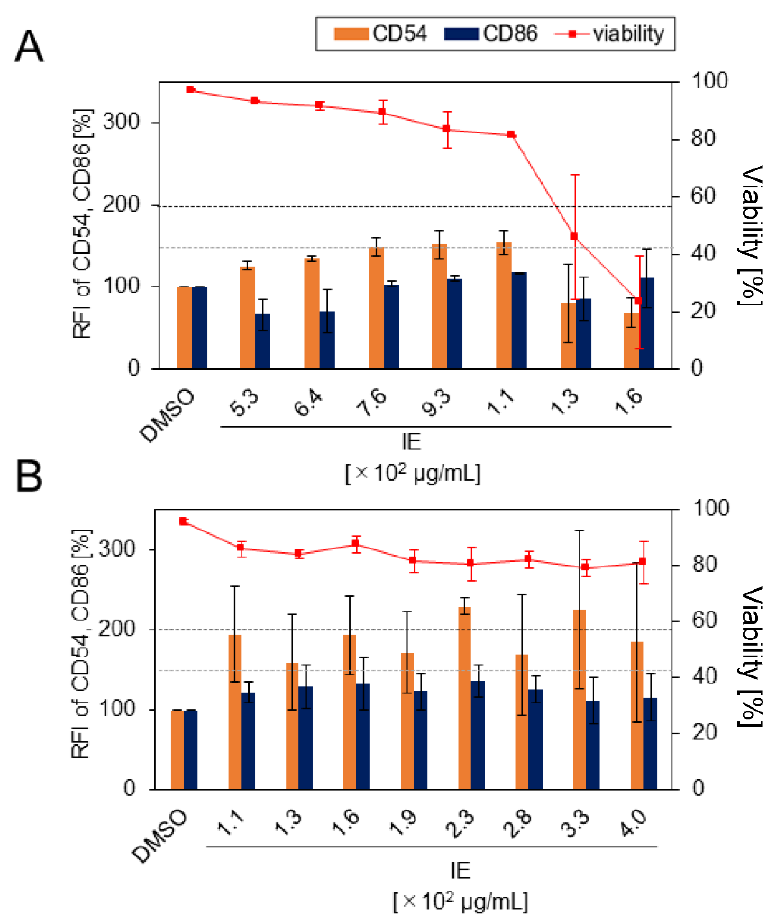
Figure 4. CD54 and CD86 expression induced by IE on THP-1 cells in monocultured ( A ) and co- cultured with keratinized NHEK cells ( B ). IE solution at eight concentrations prepared based on the CV75 determined for each exposure route was directly exposed to THP-1 cells ( A ), on the other hand, was applied on the surface of keratinized NHEK cells in cell culture insert ( B ). After 24 h of incubation, the expression of CD54 and CD86 and cell viability were analyzed using flow cytometry. Data are shown as relative fluorescence intensity (RFI, % of control). Mean values of RFI ± SD for three individual experiments are shown. The black and gray dashed lines visually indicate the positive criteria for skin sensitization in h-CLAT for CD54 and CD86, respectively (CD54 ≥ 200%, CD86 ≥ 150%).